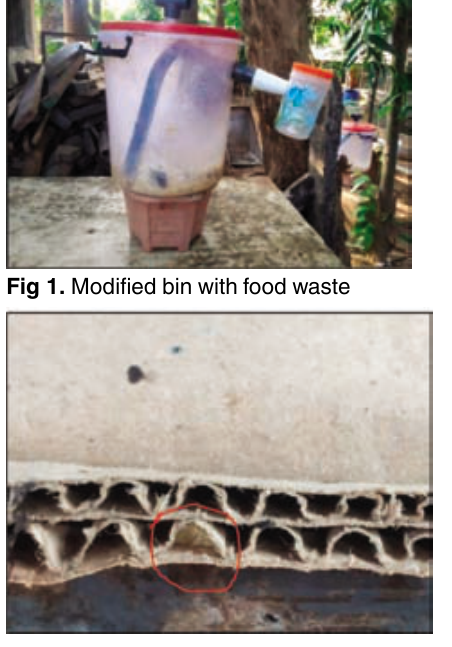
Fig 3. Egg of BSF Fig 4. Black soldier fly